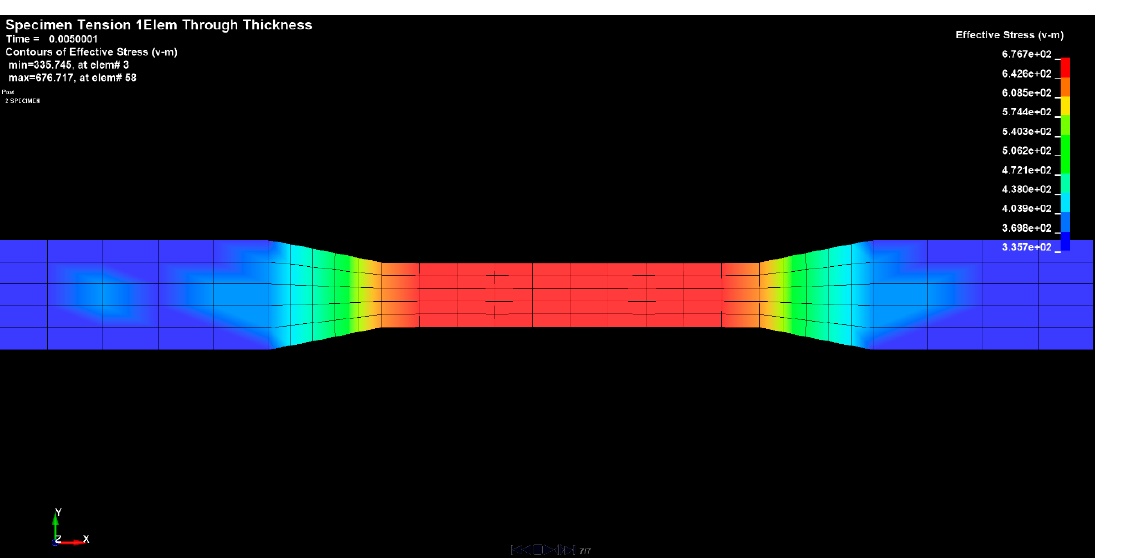
Figure 25. Sample tension in the 𝑦 direction.